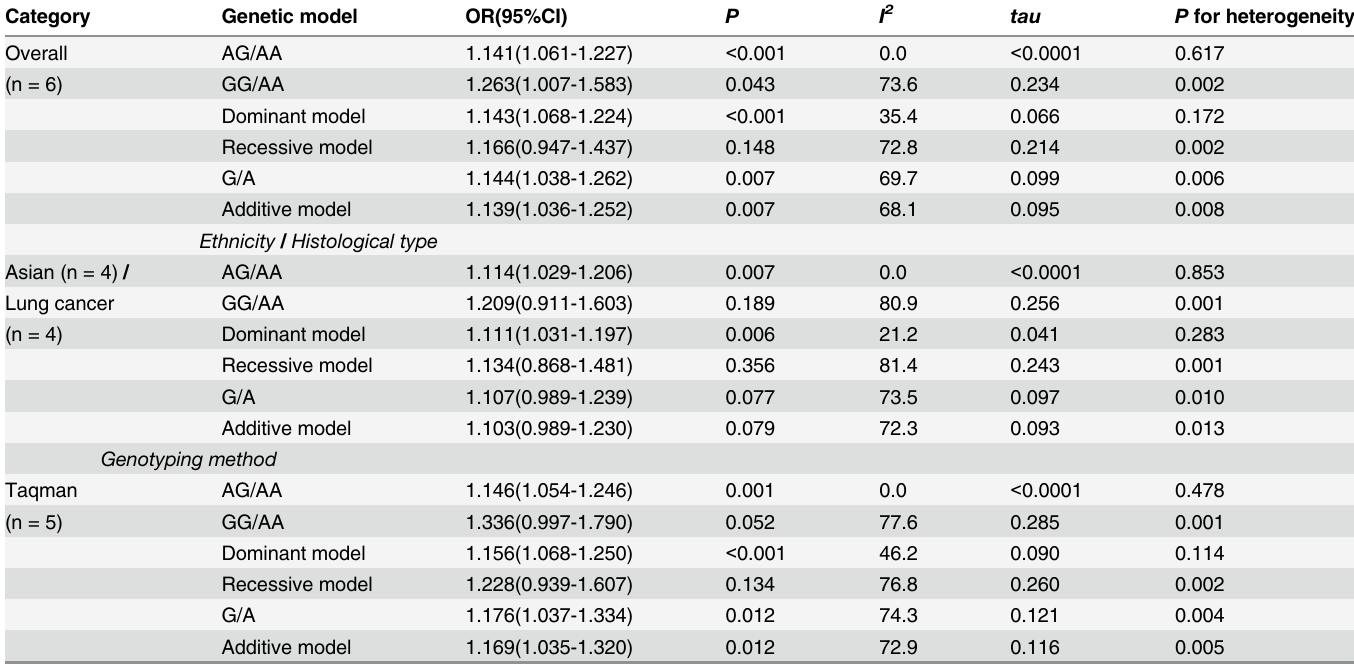
Table 4. Meta-analysis of the rs931794 in association with lung cancer risk.